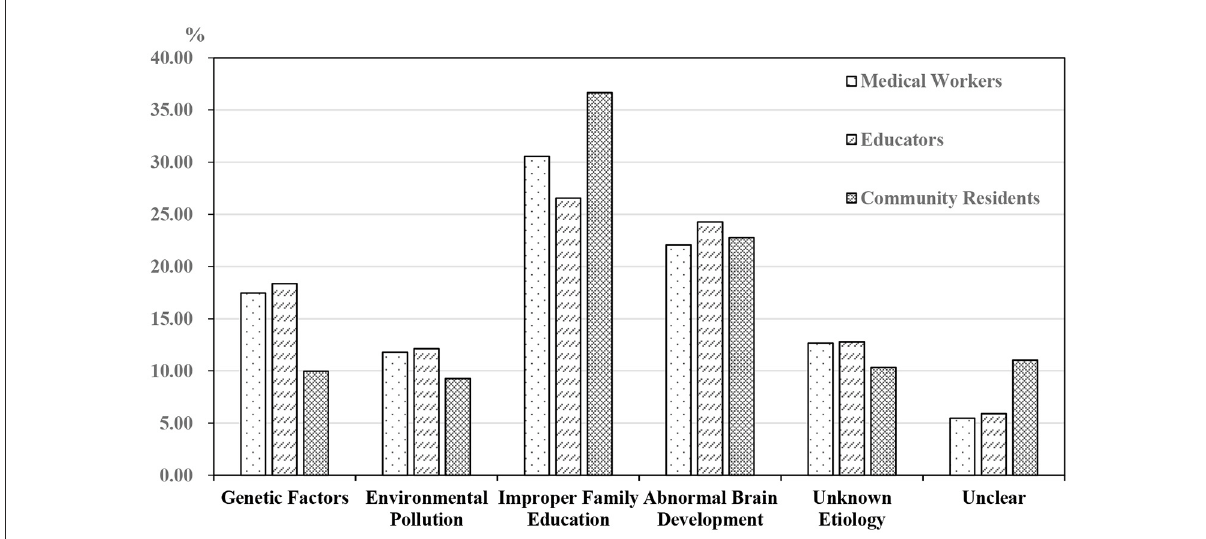
FIGURE1 Awareness of the causes of autism. The question is what do you think is the possible cause of autism? The answer is multiple choice, but if the choice is “unclear,” the respondents can’t choose other options.